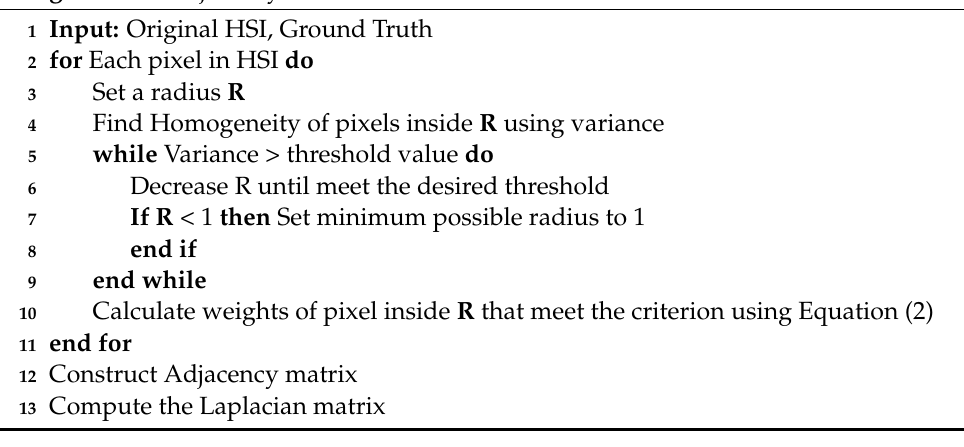
Algorithm 1 Adjacency Matrix for